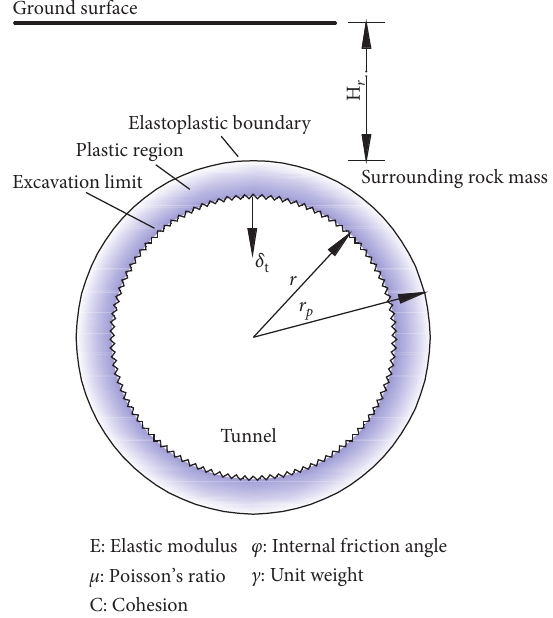
Figure 2: Circular tunnel size and surrounding rock